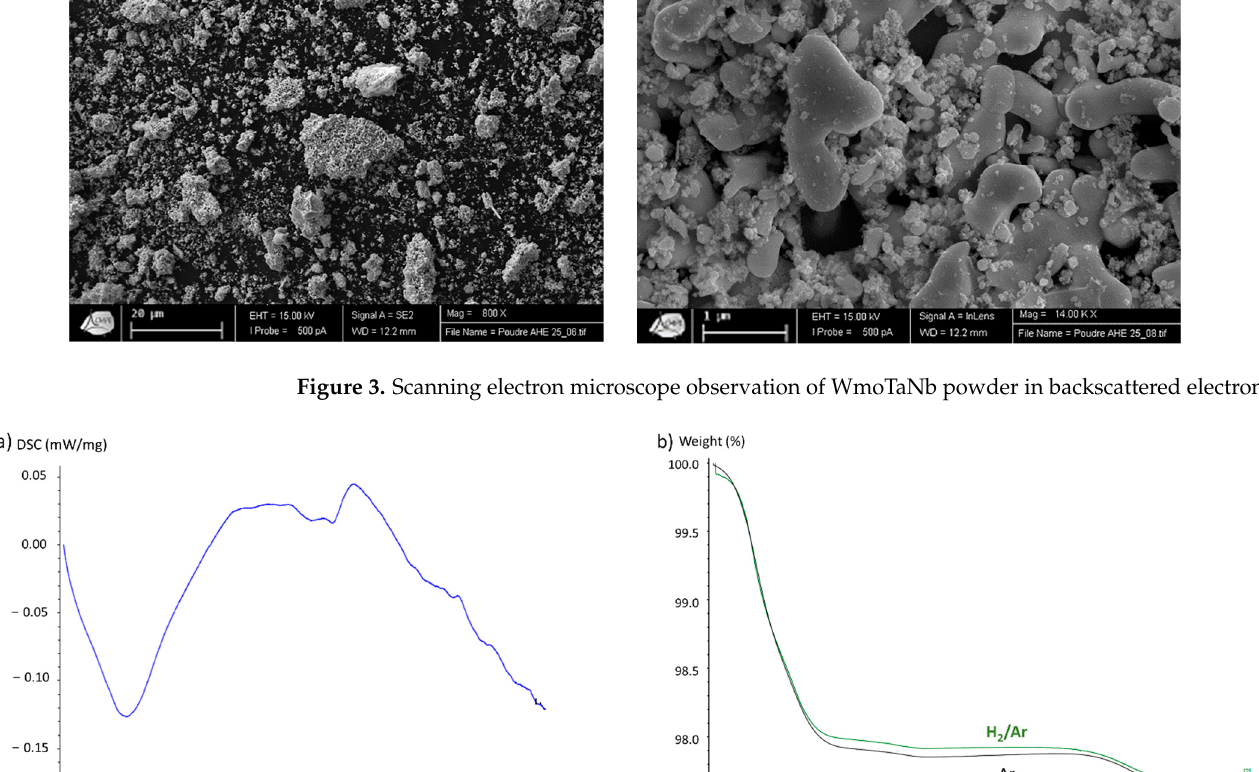
Figure 4. ( a ) DSC analysis of WmoTaNb powder under Ar. ( b ) Thermogravimetric analysis of the milled powder under Ar and Ar/H 2 . milled powder under Ar and Ar/H 2